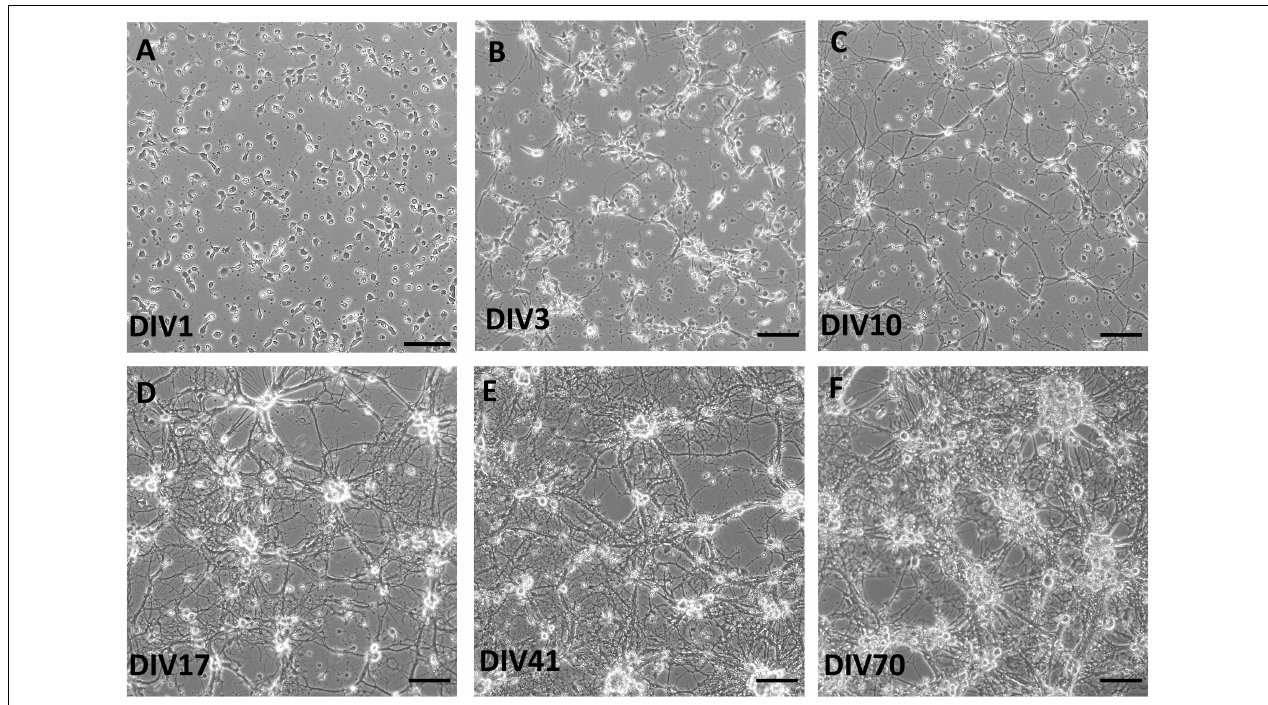
FIGURE 1 | Brightfield images of live spinal cord culture in day in vitro (DIV) 1 (A) , DIV3 (B) , DIV10 (C) , DIV17 (D) , DIV41 (E) , and DIV70 (F) . Growth of processes was observed already at DIV3, while more complex network occurred in older cultures, after DIV17. Scale bars: 50 µ m.